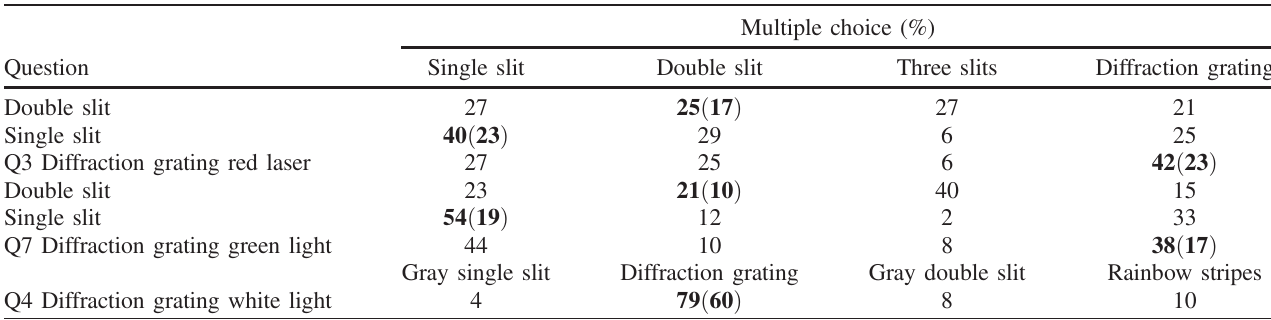
TABLE I. The percentages of students that selected a particular multiple choice (single-slit pattern, double-slit pattern, three-slits pattern, diffraction grating pattern) in each question. The correct answer is in bold. The values in parentheses are the percentages of the correct answers after the correction based on students ’ paper and pencil answers.